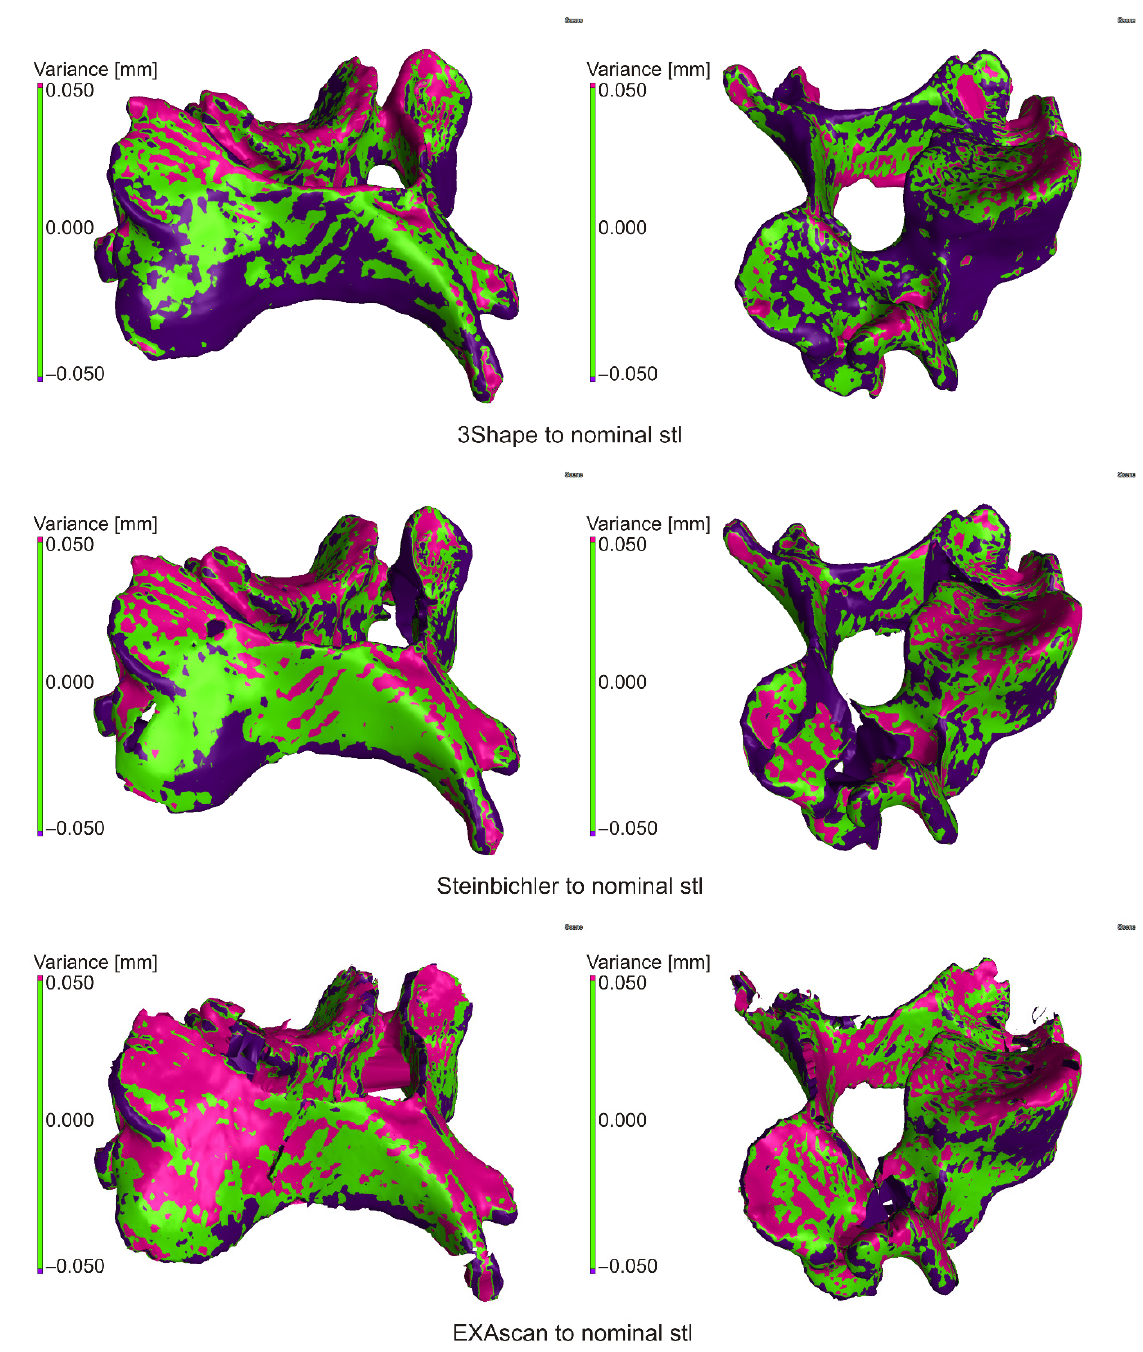
Figure 7. Comparison of scanner outputs with the reference model.